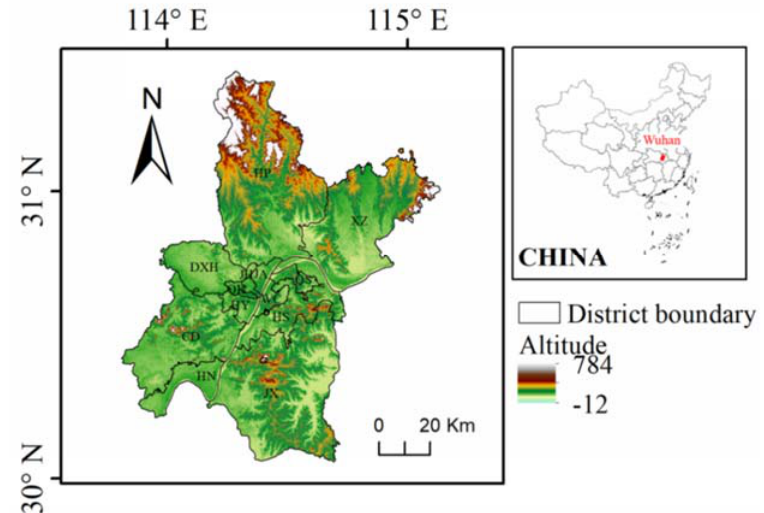
Figure 1. Location and altitude (m) of Wuhan city.